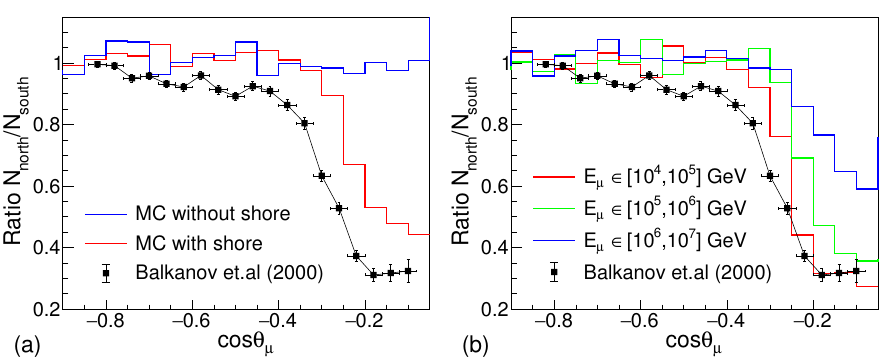
Figure 8. Comparison of simulation with data presented in Balkanov et al. [4]. ( a ) The simulation results with the entire energy range with and without the shore, and ( b ) the simulation results in different ranges of E µ